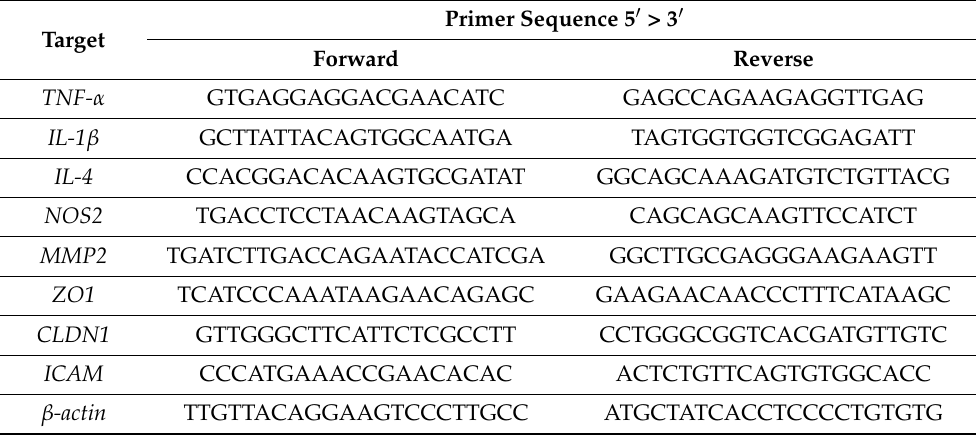
Table 1. Primers used for real-time PCR analysis of gene